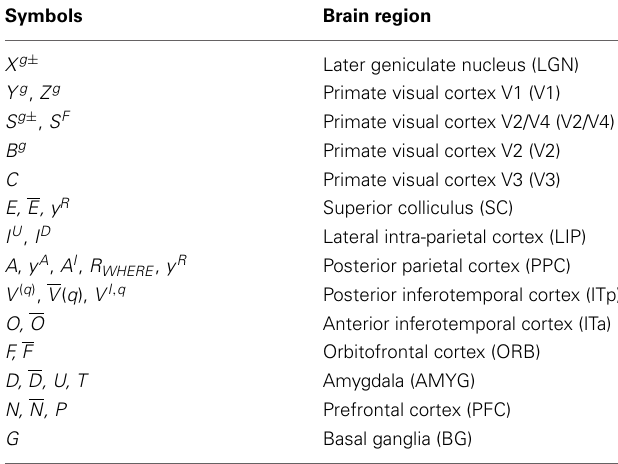
Table A1 | The variables in the mathematical equations that represent the model brain regions.